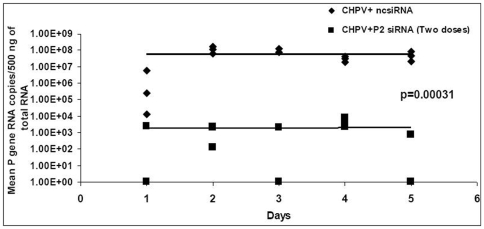
Reduction in the levels of CHPV replication in mice brain.Each day, brain homogenates from 3 mice were taken for RNA isolation and used for real time RT-PCR. Each symbol represents individual mouse. Data are shown only till all mice in control group died.